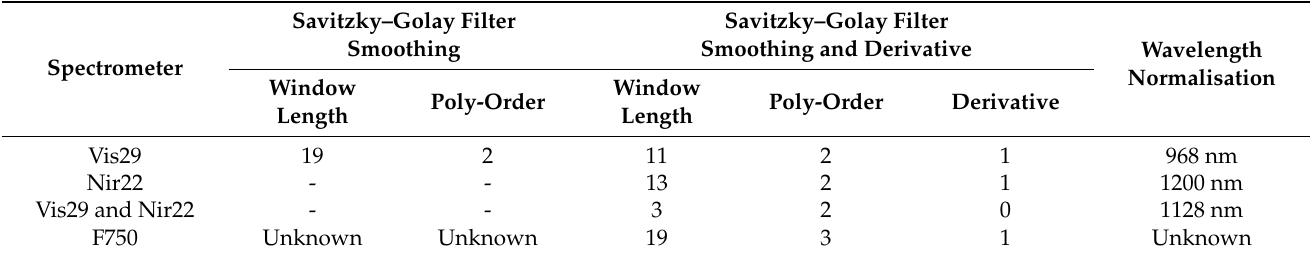
Table 3. Overview of algorithm-selected hyperparameters.